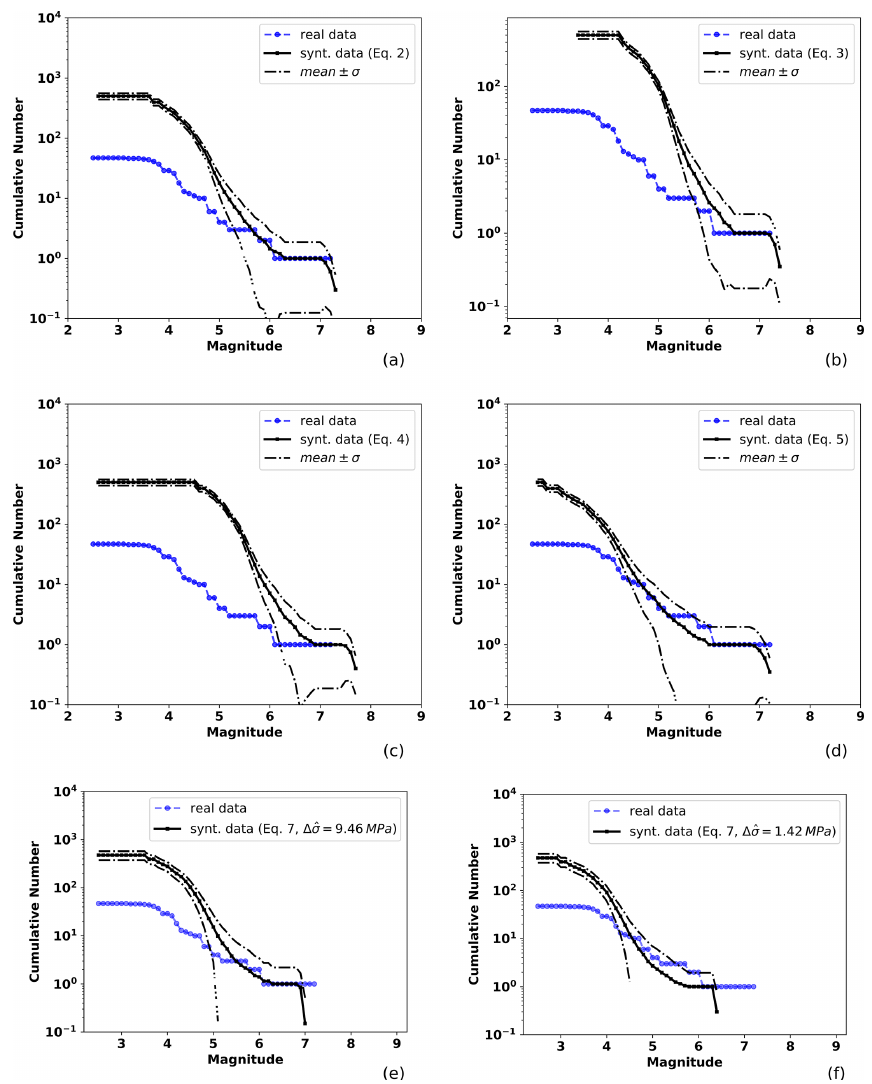
Figure 4. Observed and TREMOL synthetic frequency–magnitude curves for SA region 1 (Table 1). The solid black line indicates the mean after 20 realizations and the broken lines the standard deviation. The blue line is the observed seismicity distribution for events from 1988 to half a year before the mainshock date (14 September 1995), including events that occurred at the depth range mentioned in the text. Each mean curve is obtained by the application of one of the four magnitude–area relations used in this work: (a) Eq. (3), (b) Eq. (4), (c) Eq. (5), (d) Eq. (6), and (e, f) Eq. (7) using the mean and median stress drop